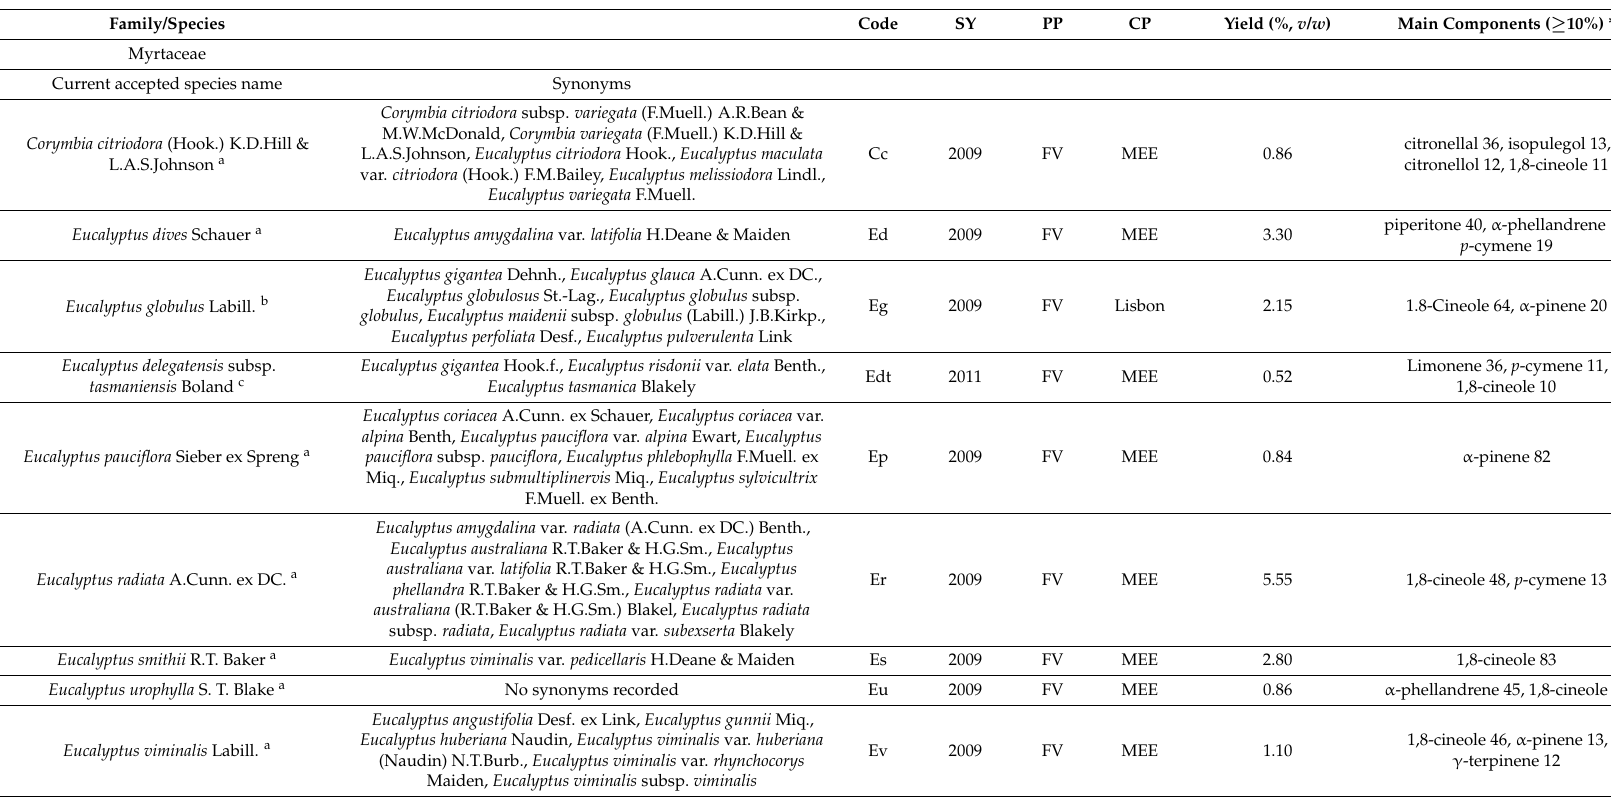
Table 1. Studied Corymbia and Eucalyptus species. Currently accepted scientific names for plant species, arranged in alphabetic order of the corresponding plant family, sampling year, plant part used for hydrodistillation, plant source, essential oil yield, and main essential oil components ( ≥